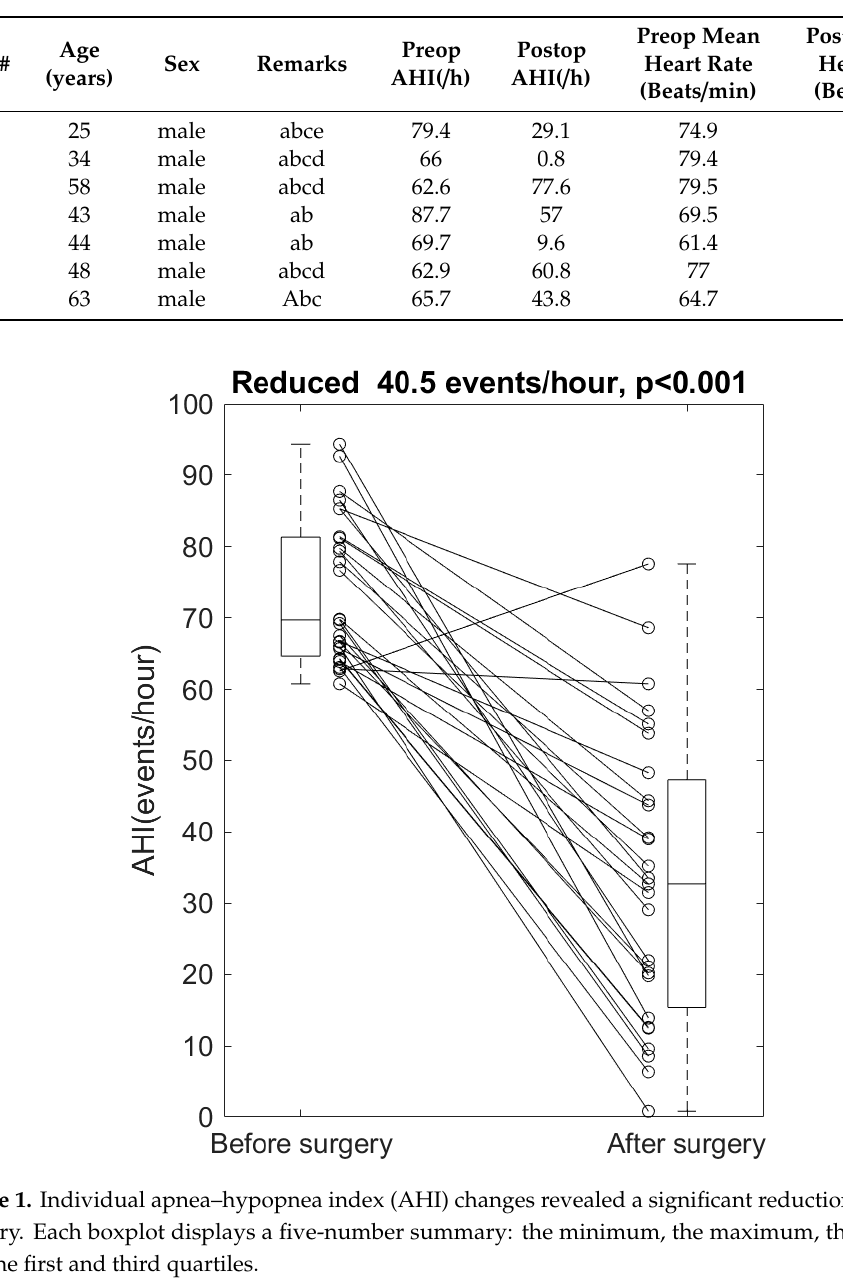
Table 1. Results for patients receiving various surgeries. Order is numbered according to the surgery